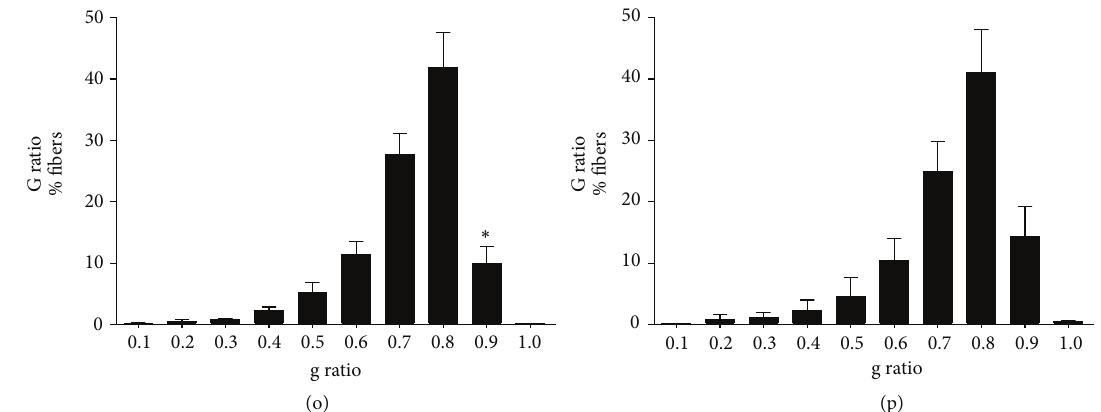
Figure 6: (a–d) Representative micrographs of estimated number of myelinated axons in the sciatic nerve, 4 weeks, following ventral root avulsion and repair. (e–h) Representative micrographs of estimated number of myelinated axons in the sciatic nerve, 12 weeks, following ventral root avulsion and repair. Scale bar = 10 𝜇 m. (i–l) Frequency distribution of fiber diameter of regenerated fibers, 12 weeks, following ventral root avulsion and repair. (m–p) Frequency distribution of 𝑔 ratio of regenerated fibers, 12 weeks, following ventral root avulsion and repair. ∗ 𝑝 < 0.05 ; ∗∗ 𝑝 < 0.01 ; ∗∗∗ 𝑝 < 0.001